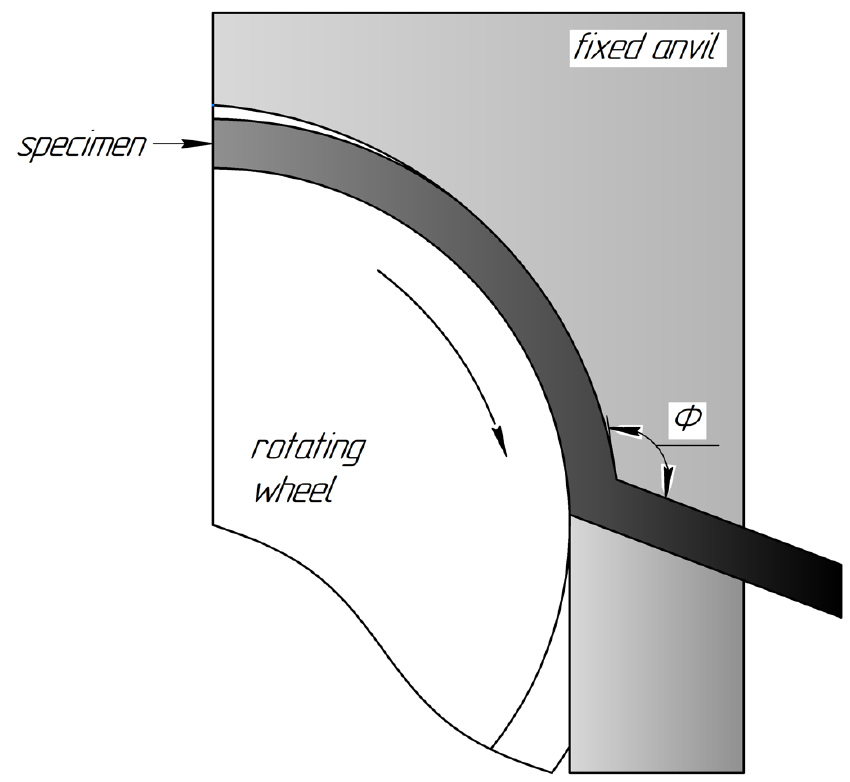
Figure 1. Schematic representation of the ECAP-C processing.